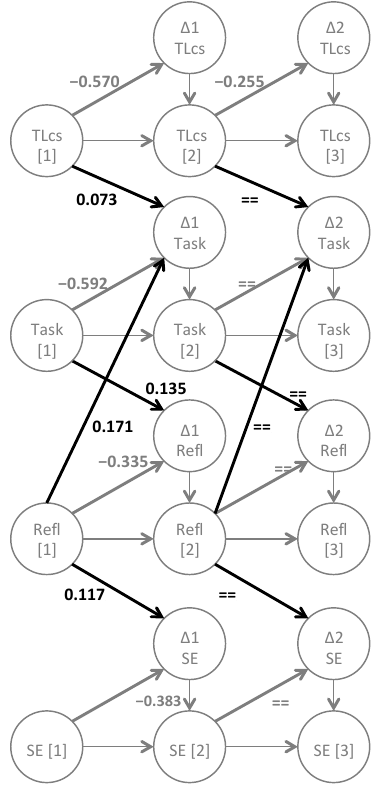
Figure 2. Simplified representation of the parsimonious multivariate proportional change Latent Difference Score (LDS)